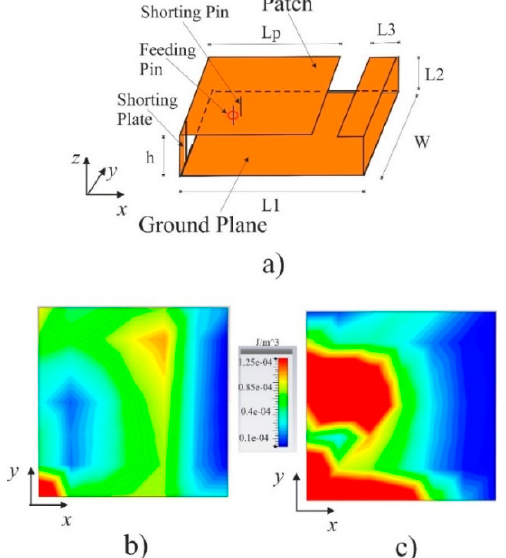
Figure 12. 3D view ( a ), of the considered antenna. ( b ) Electric and ( c ) Magnetic energy densities close to the ground plane, at the resonant frequency. L 1 = 26 mm, L 2 = 3.5 mm, L 3 = 2.5 mm, W = 26 mm, L p = 20.5 mm, h = 3.5 mm.